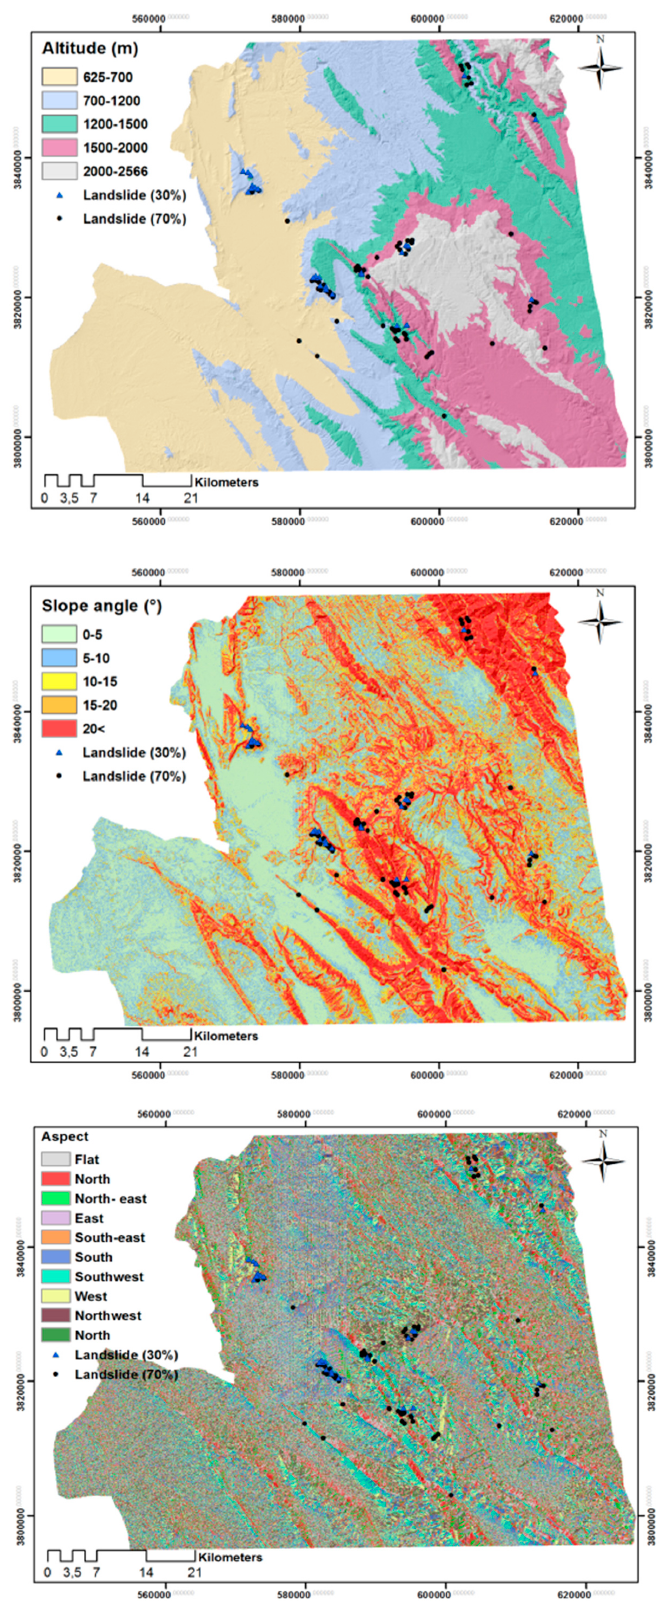
Figure 5. The representation of landslide conditioning factors of slope angle (°), altitude (m), and aspect.